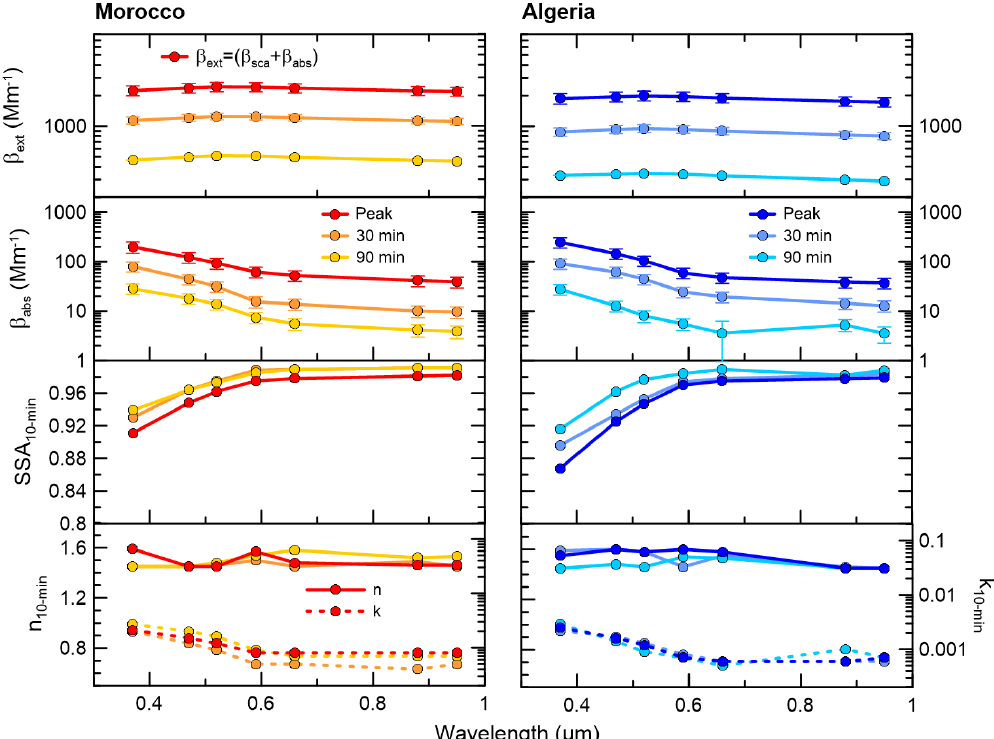
Figure 5. Spectral extinction coefficient, absorption coefficient, SSA, and real ( n ) and imaginary ( k ) parts of the refractive index at the peak of the dust injection in the chamber and after 30 and 90min for Morocco and Algeria dust samples. Data are reported at the seven aethalometer wavelengths (370, 470, 520, 590, 660, 880, and 950nm) as 10min averages. In the top panels we report the extinction calculated as the sum of scattering and absorption coefficients. For the sake of clarity error bars are not shown for SSA, n , and k